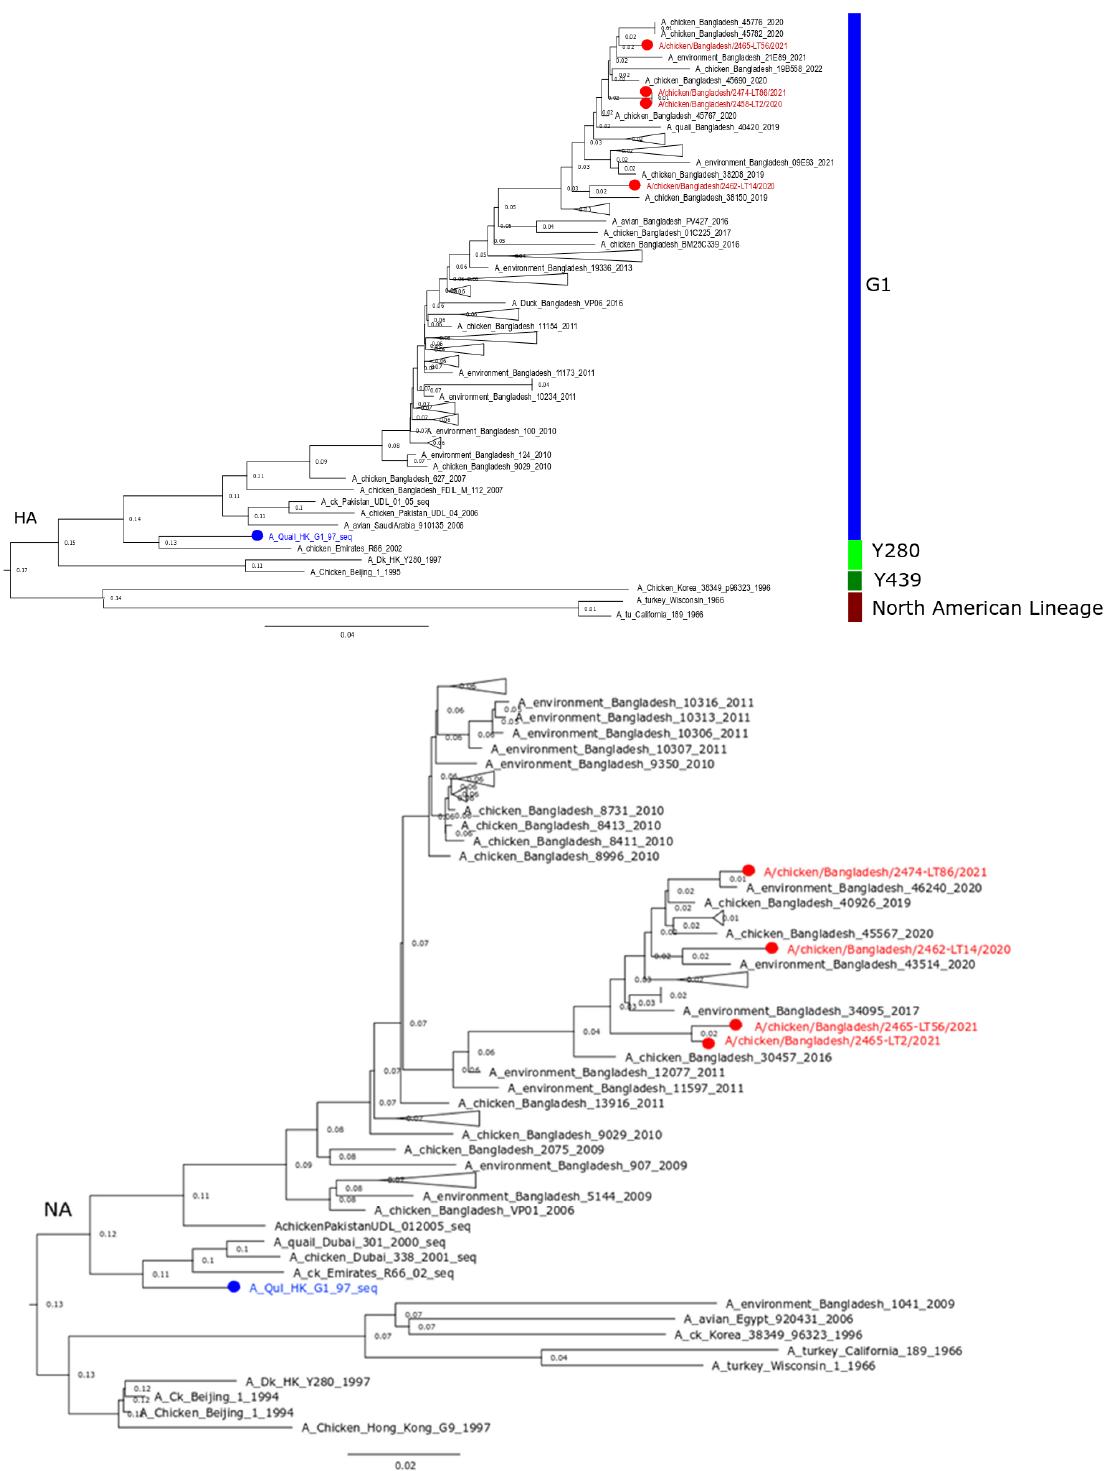
Figure 2. Phylogenetic tree for HA ( upper ) and NA ( lower ) genes of recent H9N2 isolates of Bangladesh. The tree was built using neighbor joining method and Jukes-Cantor substitution model incorporated in the MAFFT package with the confidence intervals estimated by applying 1000 boot- strap algorithm. Red color taxa with circle indicate studied Bangladeshi isolates. Blue color taxa represent G1 reference